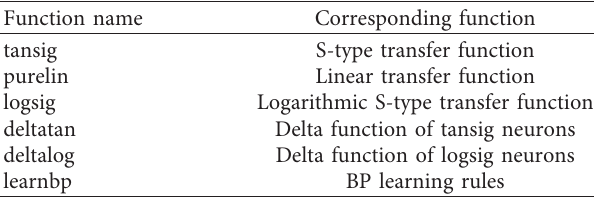
Table 1: Important functions and functions of some BP